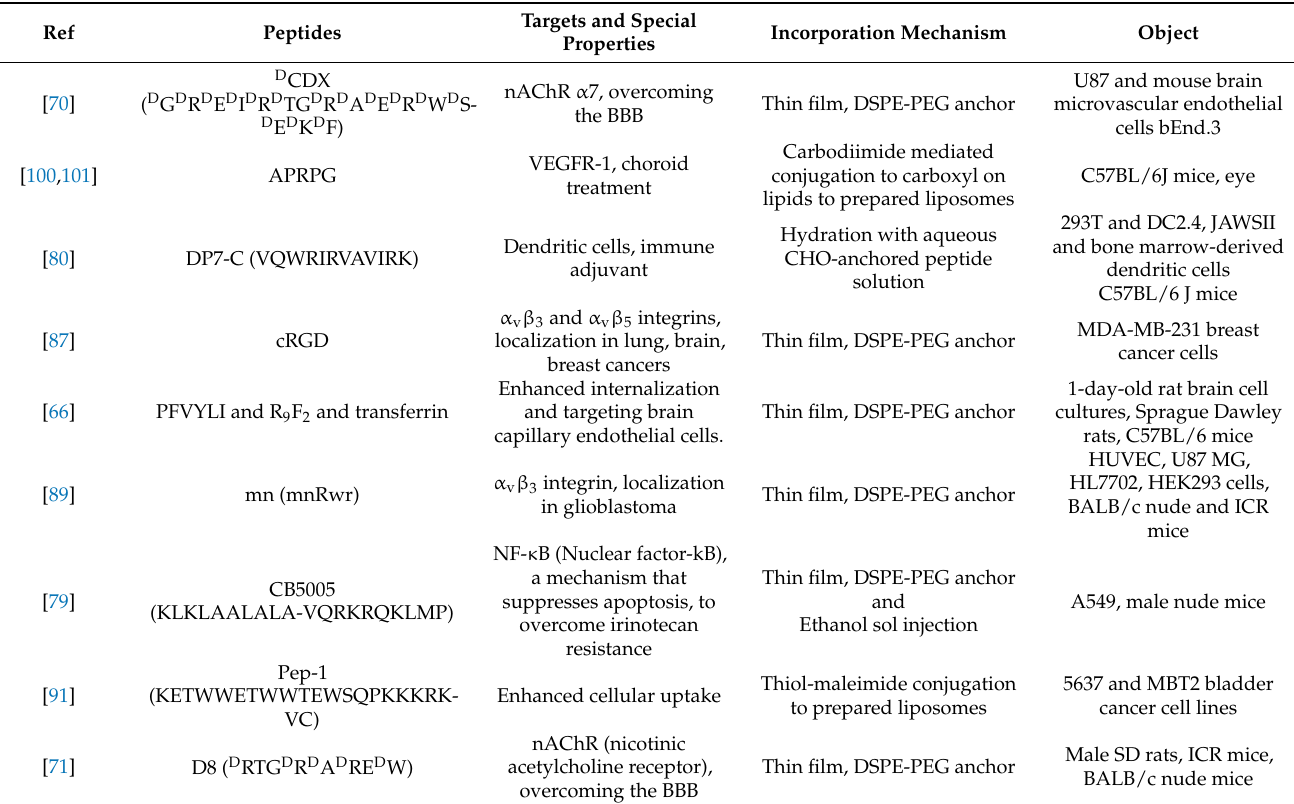
PFVYLI and R 9 F 2 and